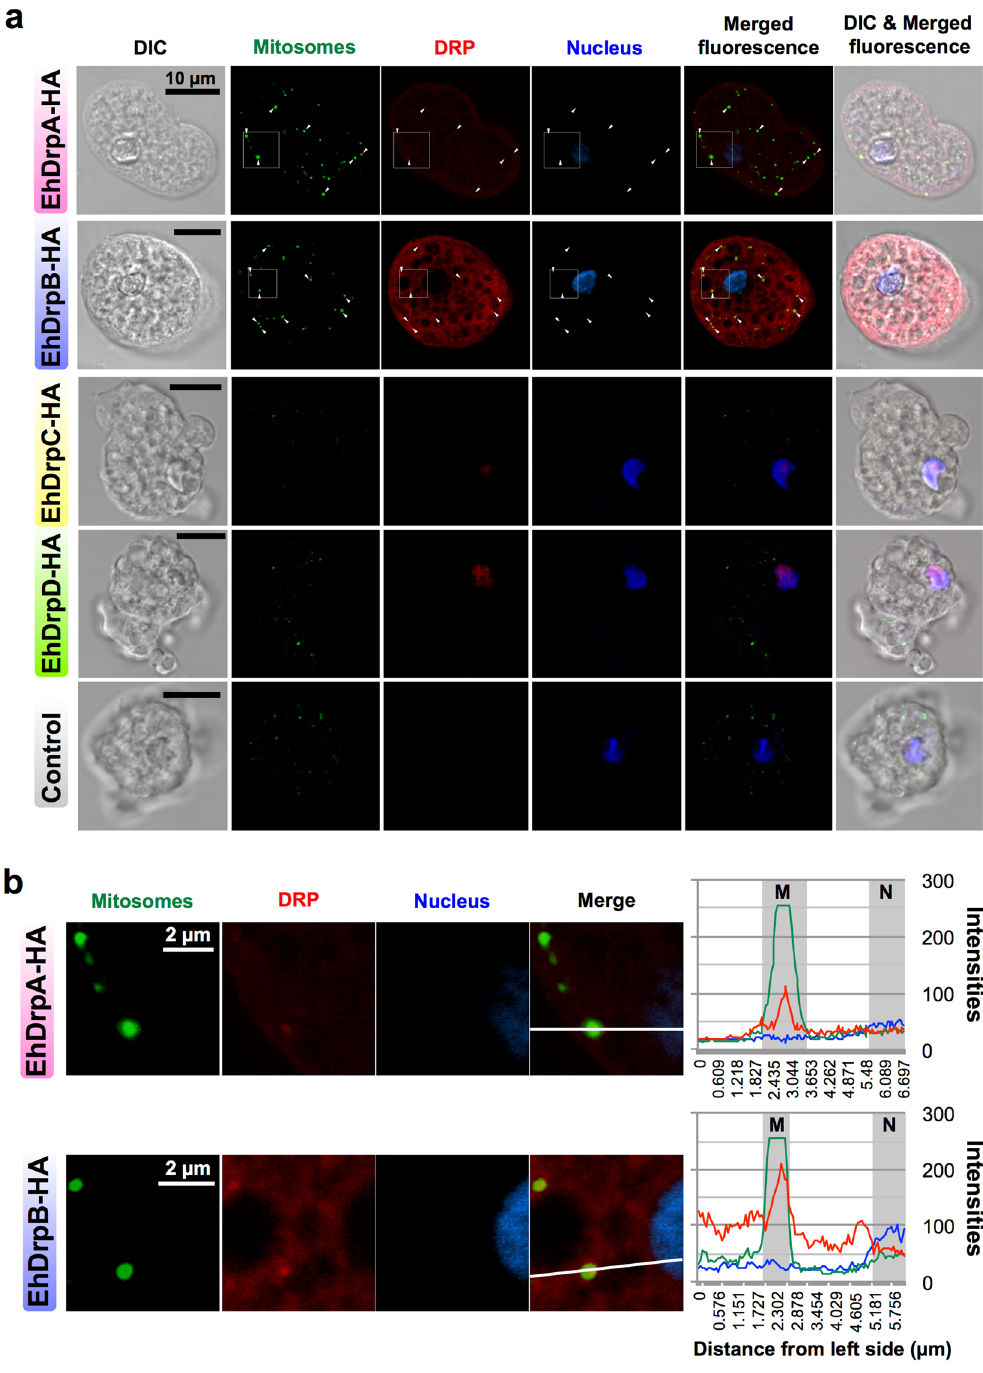
Figure 2. Indirect immunofluorescence analysis of the localization of E . histolytica DRPs by confocal microscopy. ( a ) Immunofluorescence images of EhDrpA-HA, EhDrpB-HA, EhDrpC-HA, and EhDrpD-HA strains. Scale bar = 10 µ m. ( b ) Magnified fluorescence images of the boxed region in Fig. 1a of EhDrpA-HA and EhDrpB-HA strains. Right graphs show the profile of fluorescence intensities on the line in merged images. M and N indicate positions of mitosomes and the nucleus on the line, respectively. Scale bar = 2 µ m. EhDrpA-HA, EhDrpB-HA, EhDrpC-HA, and EhDrpD-HA (red) were stained using anti-HA antibody and Alexa Fluor ® 594 goat anti-mouse IgG (Life Technologies). Mitosomes (green) were stained by antibody against APS kinase (APSK, mitosomal matrix protein, XP_656278) and Alexa Fluor ® 488 goat anti-rabbit IgG (Life Technologies). Nuclei were stained with 1 µ g/ml TOTO-3 (Life Technologies) in DABCO (SIGMA). Merged images of differential interference contrast (DIC) and fluorescence are also shown. These images are approximately 1.0 µ m in thickness per section. Arrowheads in Fig. 1a indicate mitosomes colocalized with the dotted signals of EhDRP-HA. Experiments were performed at least twice and more than 50 cells were observed for each